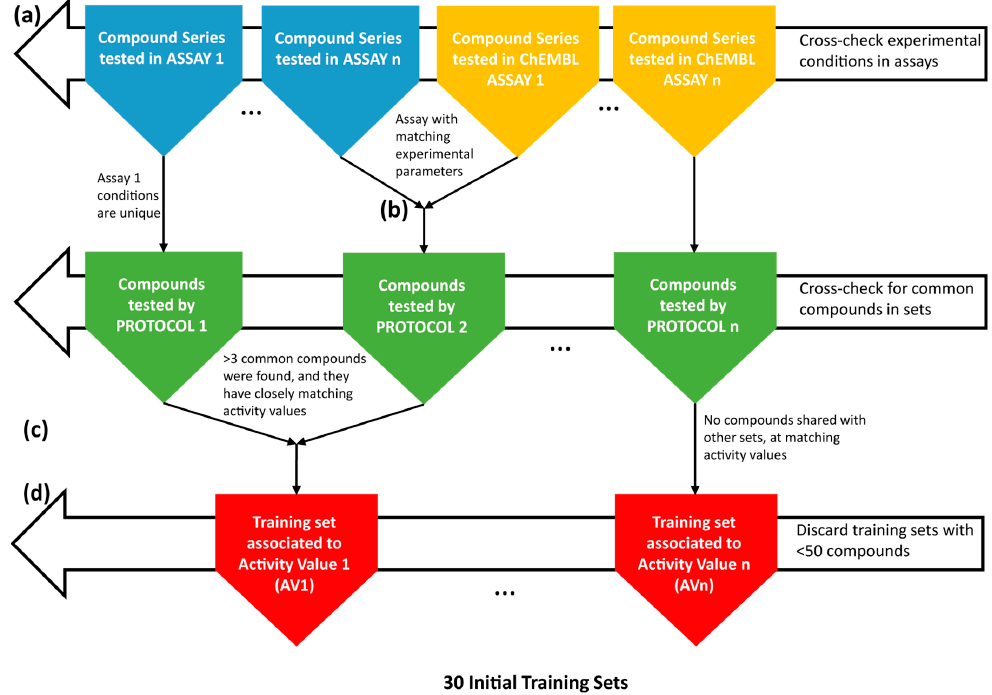
Figure 3. Antimalarial data merging, from various sources to QSAR model training sets. Collecting experimental series ( a ), merging of experimental series into training sets ( b , c ), final training sets ( d ).